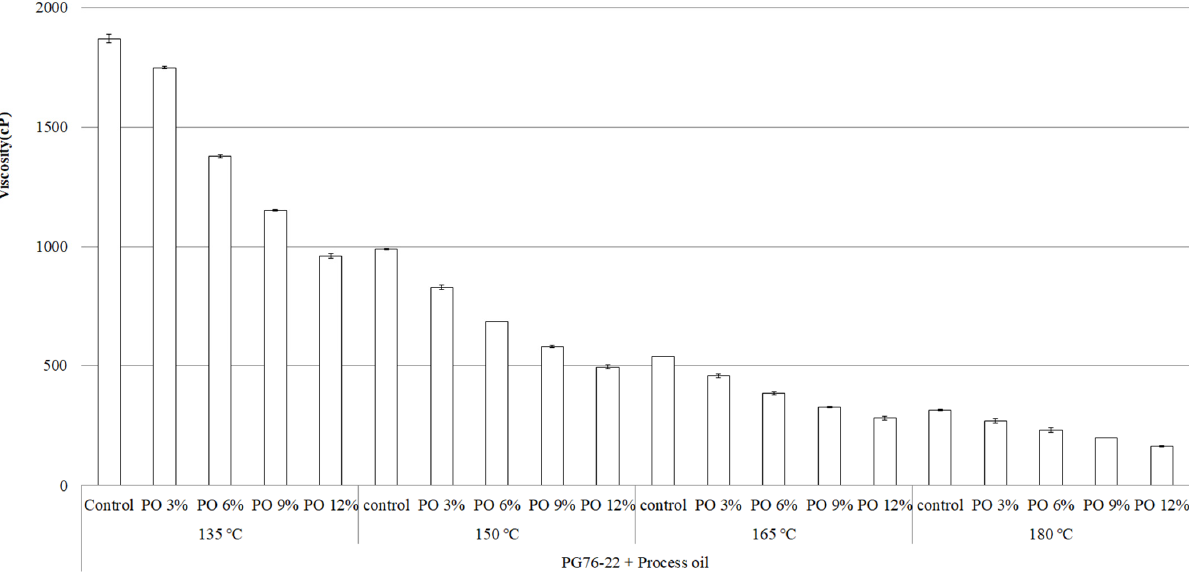
Figure 4. Viscosity of PG 76 ‐ 22 binder as a function of processed oil content and temperature incre ‐ ment.